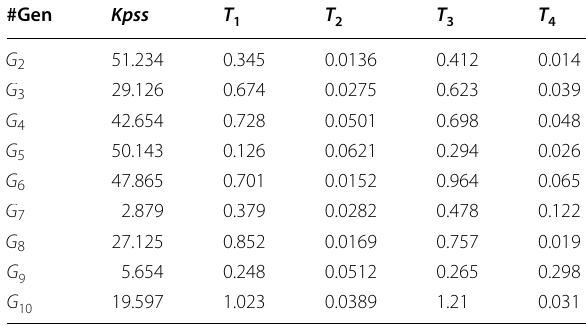
Table 8 Evolved parameters of PSS for case 2 using